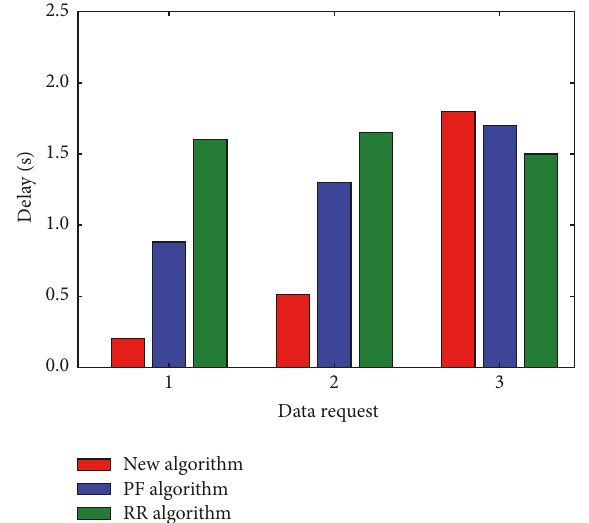
Figure 7: The delay of different business under different